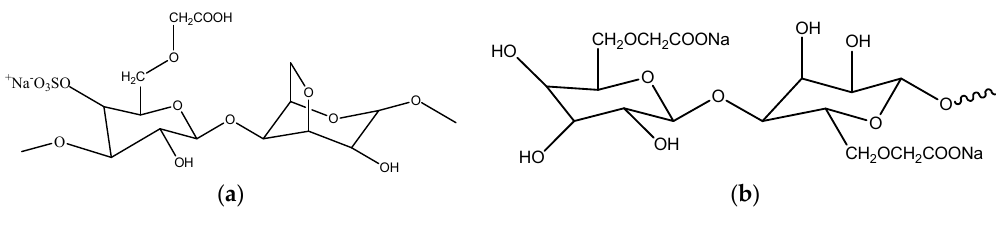
Figure 1. ( a ) Structure of CMKC; ( b ) Structure of CMCE.